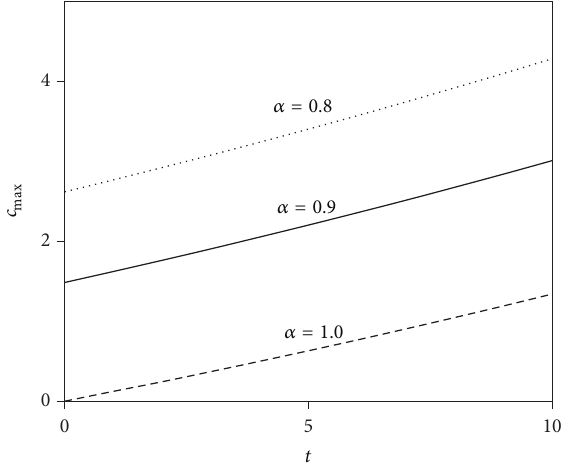
Figure 4: Service level change of the centralized supply chain with/without RFID technology.